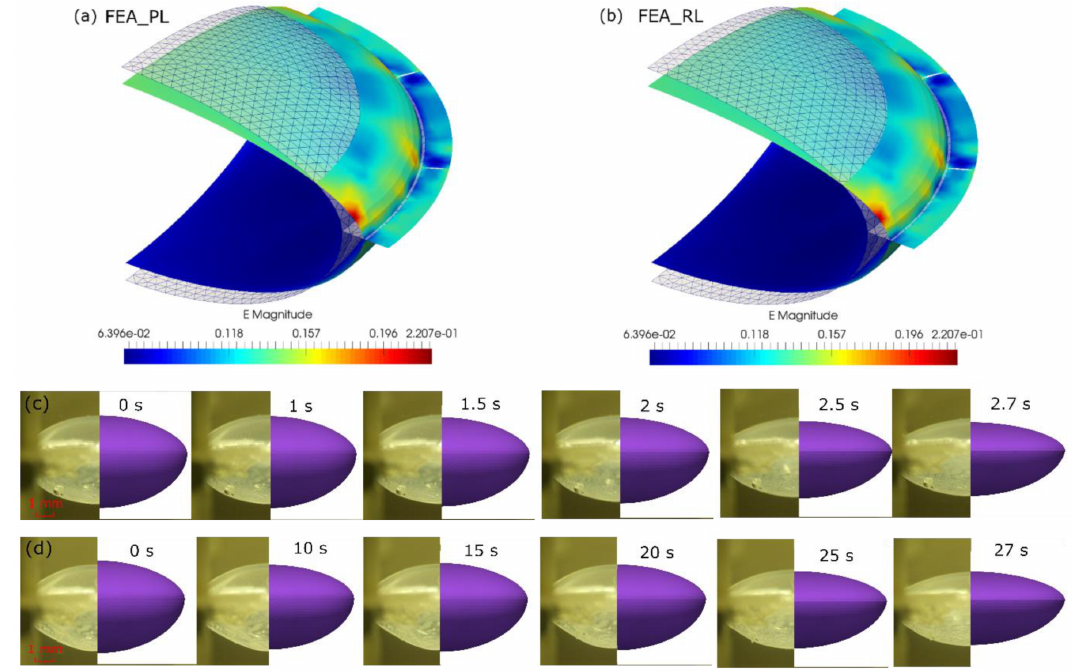
Figure 9. Shape change of ALC under accommodating: ( a ) initial shape and strain profile of deformed shape by FEA _PL; ( b ) initial shape and strain profile of deformed shape by FEA_RL; ( c ) comparison between experiment and FEA_RL (NS = 0.5 mm/s); ( d ) comparison between experiment and FEA_RL (NS = 0.05